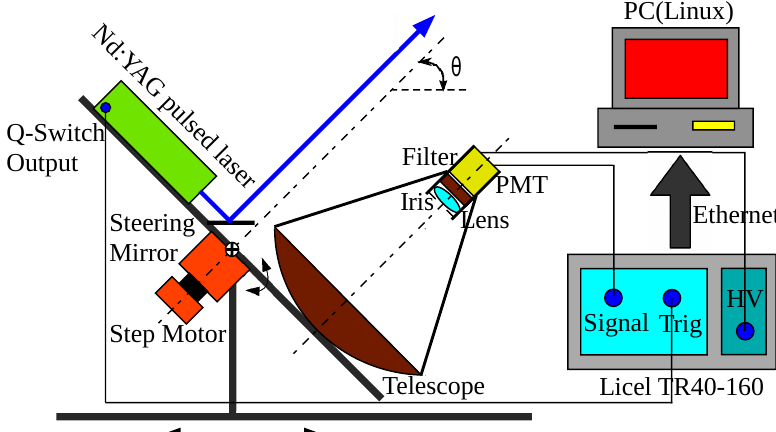
Figure 1. Schematic diagram of the scanning elastic backscatter LiDAR system. The direction of the LiDAR in the elevation angle θ can be changed from − 5 ◦ to 90 ◦ , while the azimuth angle is fixed. The axis of rotation for the elevation angle scanning is denoted by ⊕